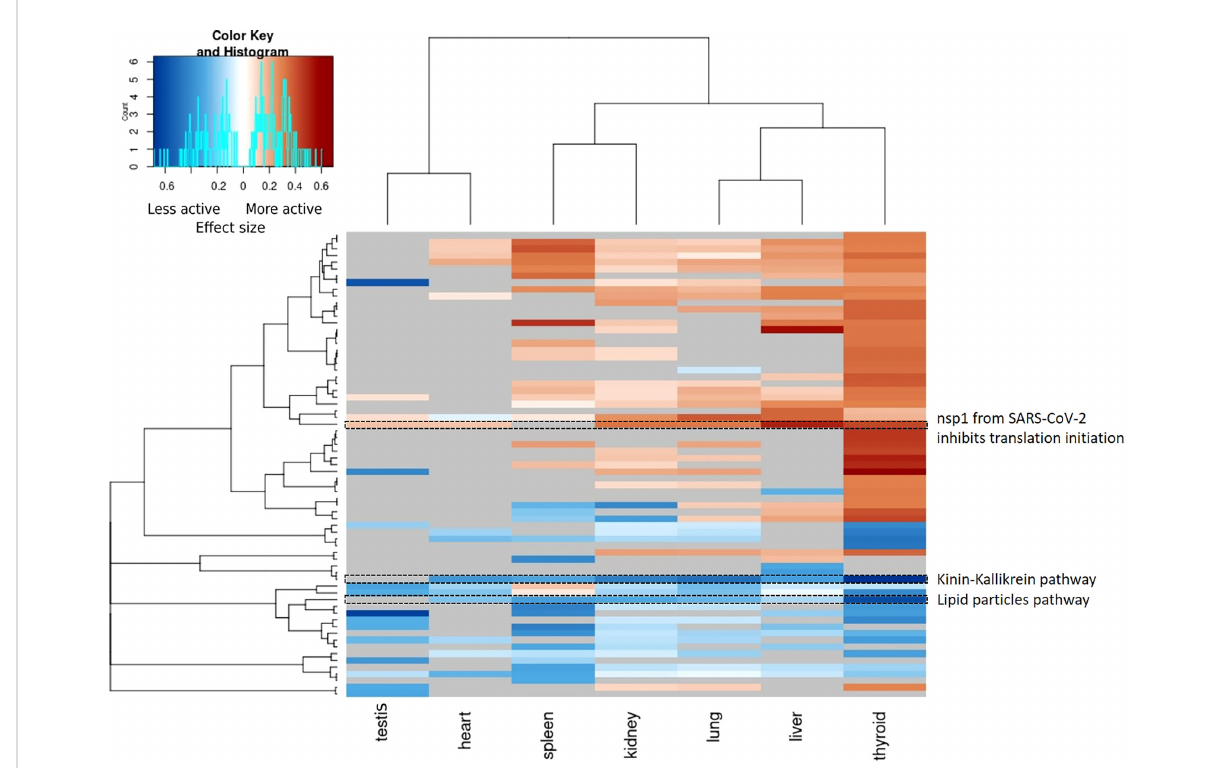
FIGURE 4 Heatmap of pathway activities per tissue (p-value < 0.05, Wilcoxon test). Pathway activities are highly tissue speci fi c and only few pathways show signi fi cant changes in multiple tissue. All signi fi cant changed pathway are shown and the color gradient indicates the effect size. Blue: the pathway is less active in COVID-19 patients, red: the pathway is more active in COVID-19 patients. Grey: unmeasured or non-signi fi cant pathways (p-value >=